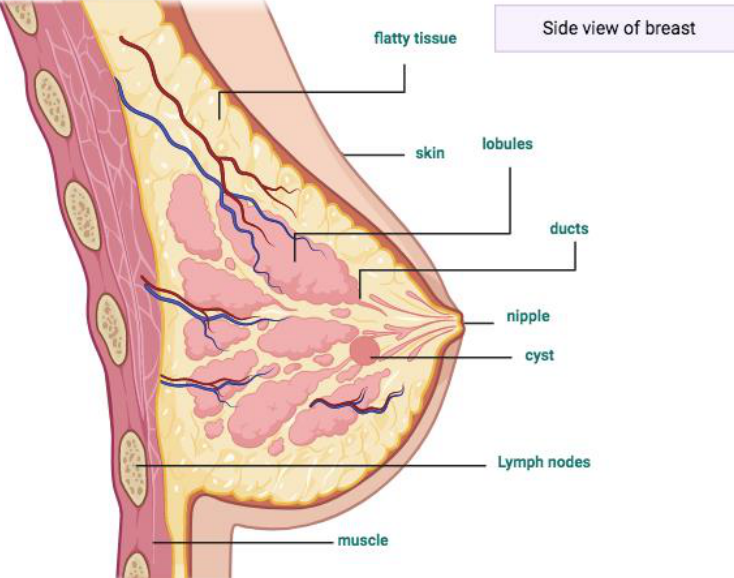
Figure 1. This scheme represents the anatomy of a woman’s breast. Inside the lobes are the zones where the epithelial tumors or cyst grow. Designed by Biorender (2020). Retrieved from https://app.biorender.com/biorender-templates